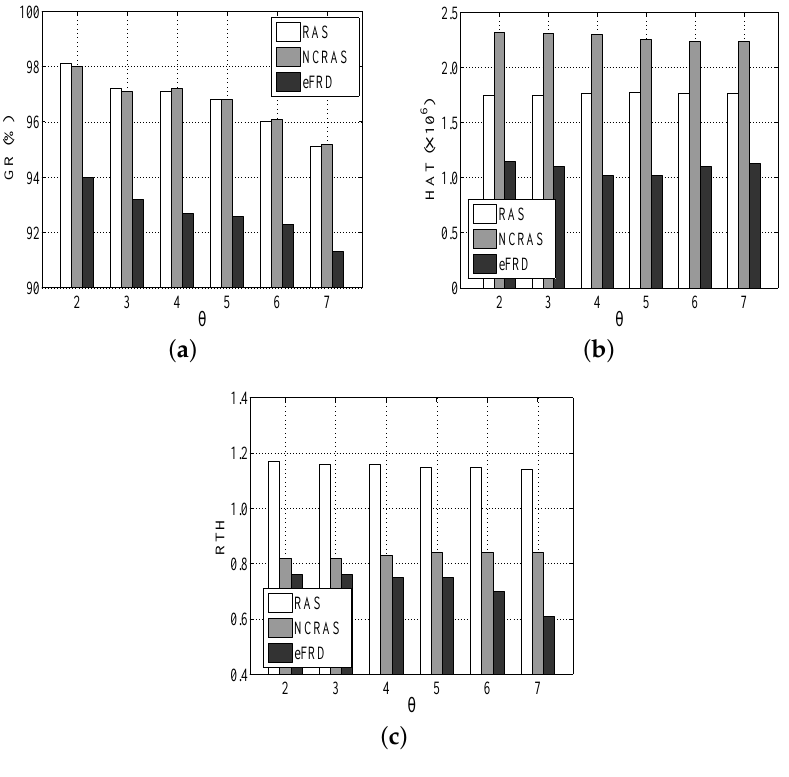
Figure 6. Performance impacts of Task Dependence. ( a ) Impact of Task Dependence on GR, ( b ) Impact of Task Dependence on HAT, ( c ) Impact of Task Dependence on